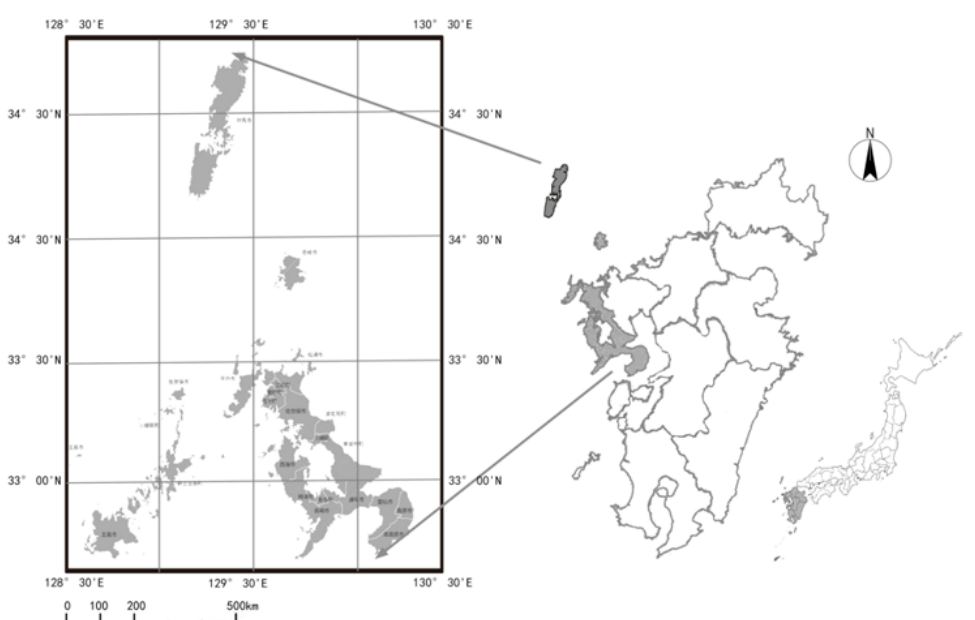
Figure 1. Location of Nagasaki Prefecture (Source: the authors).